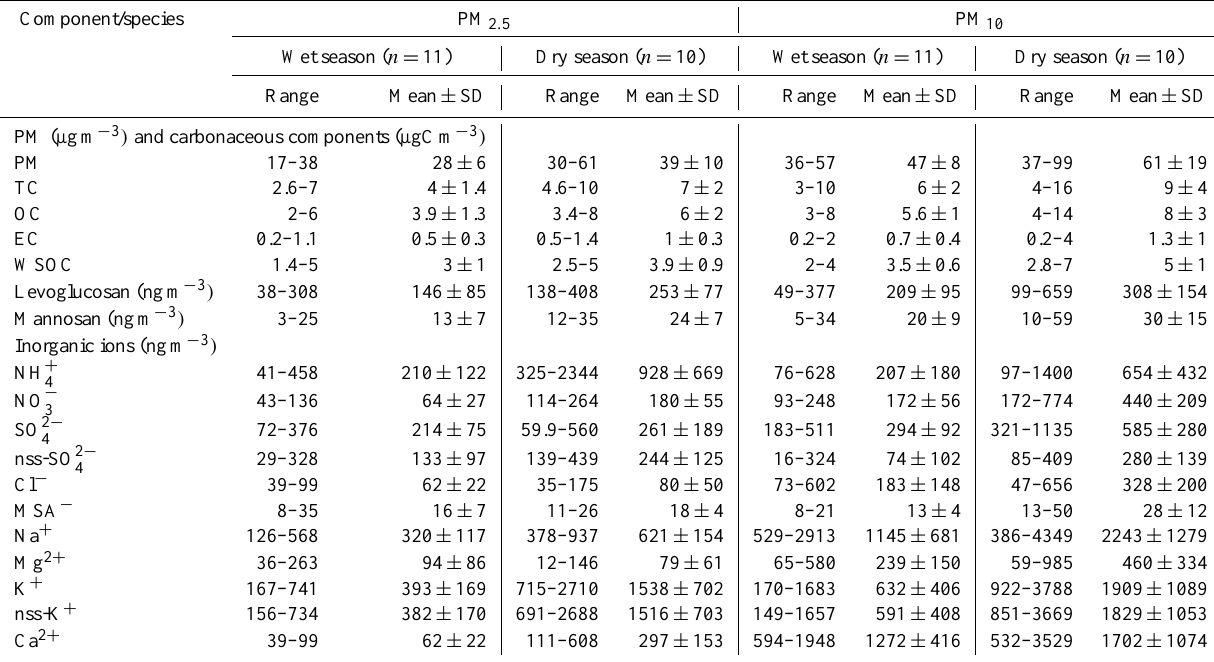
Table 1. Mean concentrations and concentration ranges of the PM mass, carbonaceous components, levoglucosan, mannosan and inorganic ions in PM 2 . 5 and PM 10 in Morogoro during the wet and dry seasons, 2011. Component/species PM 2 . 5